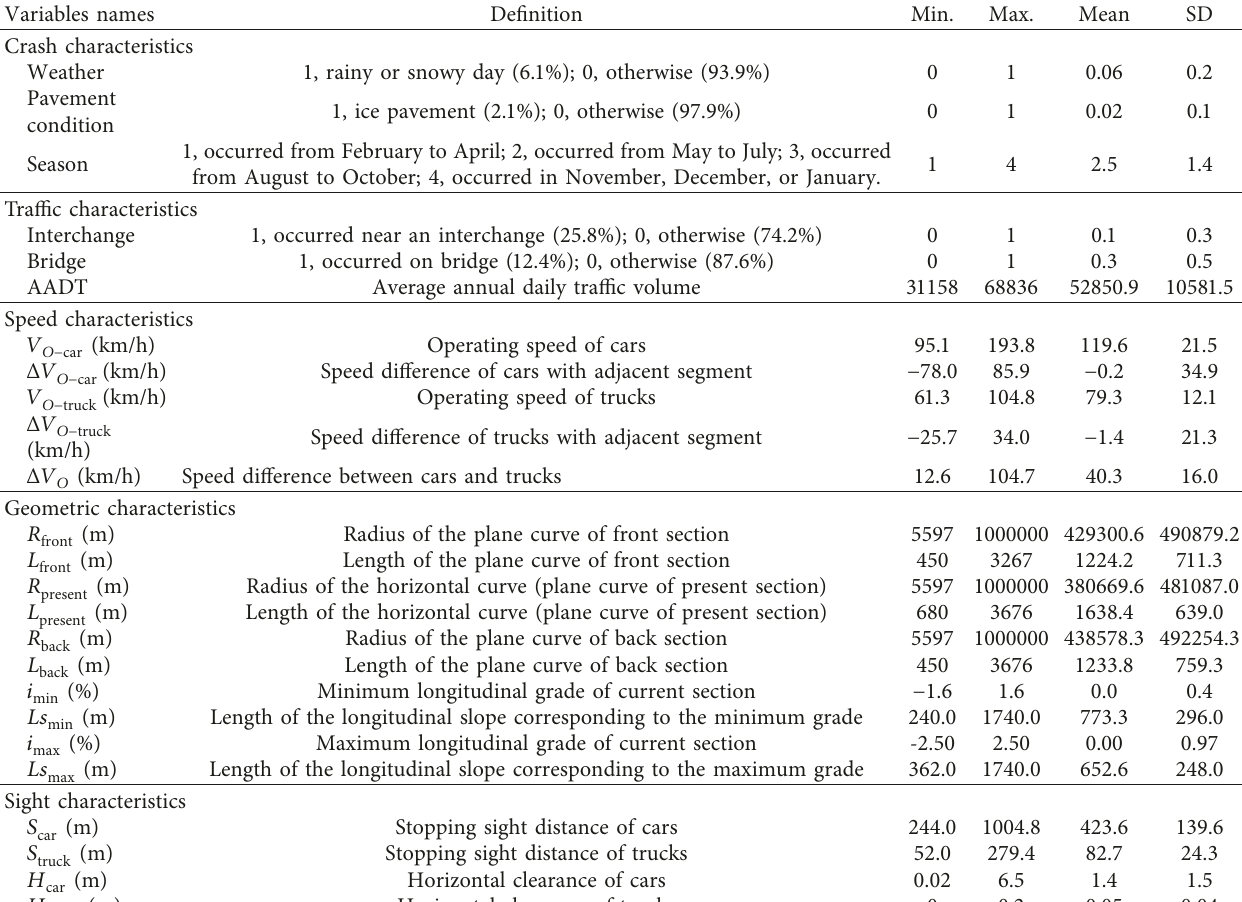
Table 3: Descriptive statistics of key variables.